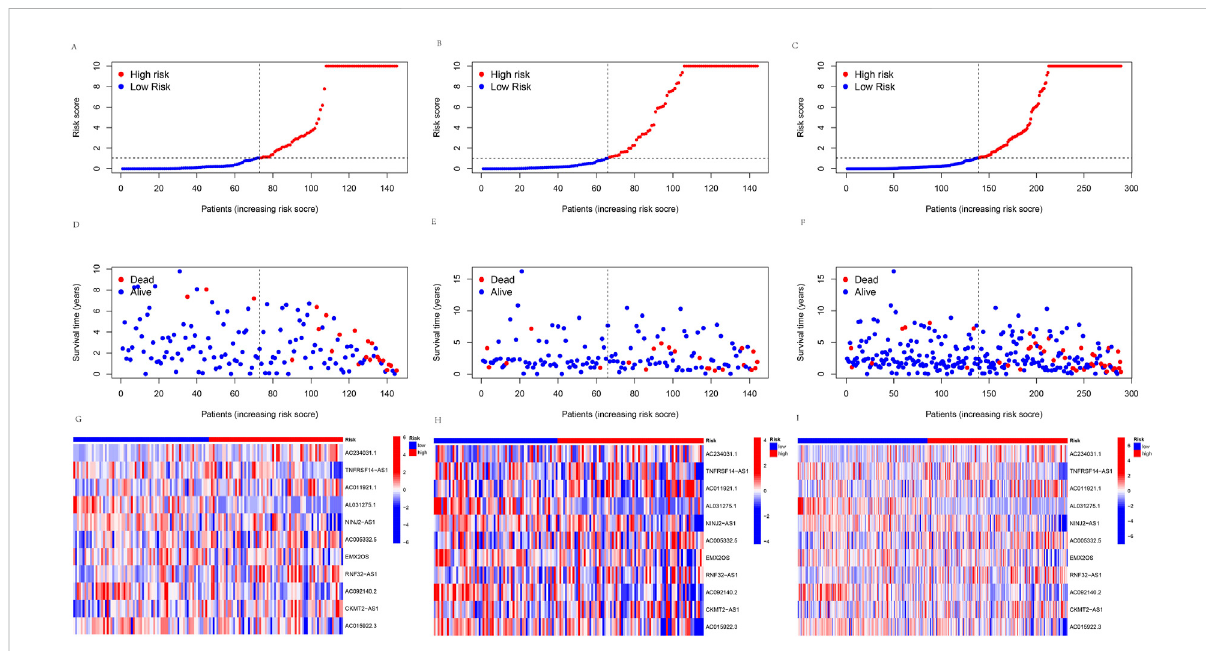
FIGURE 4 Predictingtheperformanceofsignature.Theriskcurveisbasedontheriskscoreforeachsampleinthe (A) traininggroup, (B) testinggroup,and (C) all groups, where red and blue dots indicate high- and low-risk samples, respectively. The scatter plot is based on the survival status of each sample from (D) the training group, (E) the testing group, and (F) all groups, where red and blue dots indicate death and survival, respectively.